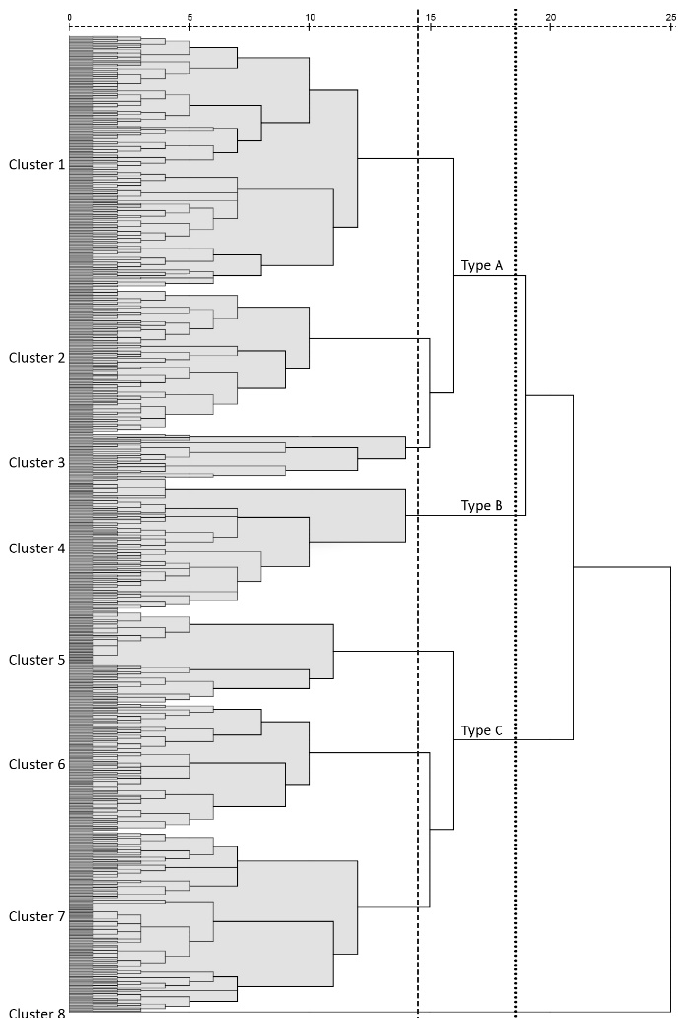
Figure 13. Dendrogram using Average Linkage (Between Groups) corresponding to the cluster analysis based on five built-environment variables. The vertical lines indicated the normalized distance at which the eight clusters (dashed) and three types (dotted) confirmed.